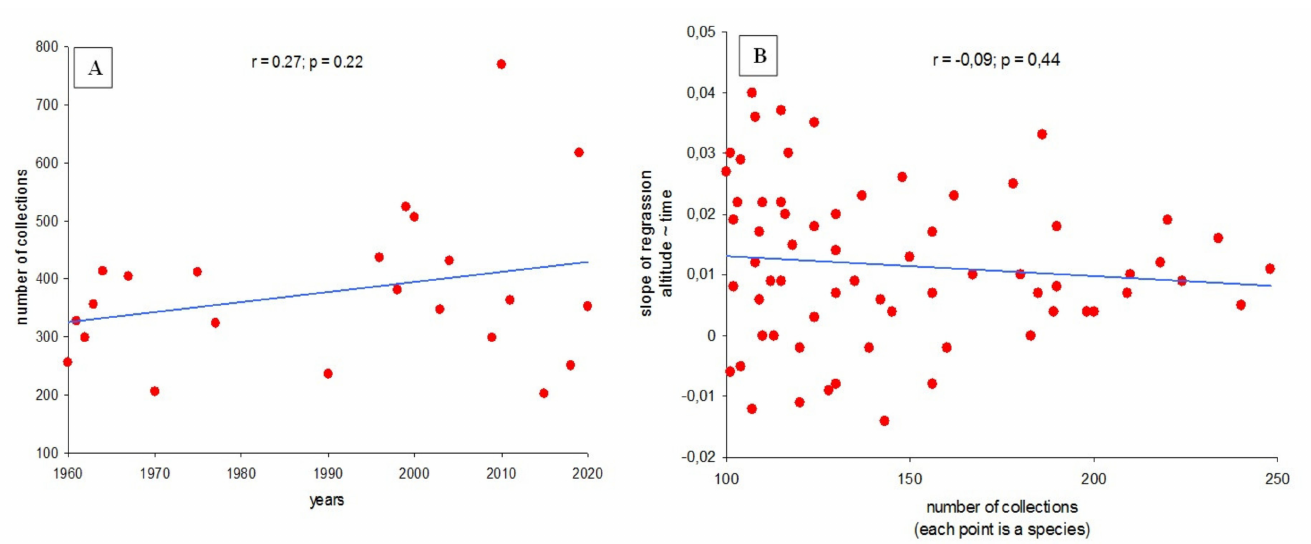
Figure 5. Total collections over 23 years ( A ) and slope of species’ estimated trends over time, as a function of their collection effort ( B